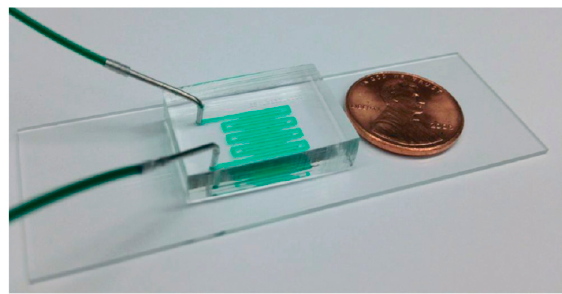
Figure 5. The microfluidic device developed by Lee et al. [41] for the immobilization of an array of worms for HTP analysis. Reprinted with permission from the Royal Society of Chemistry.